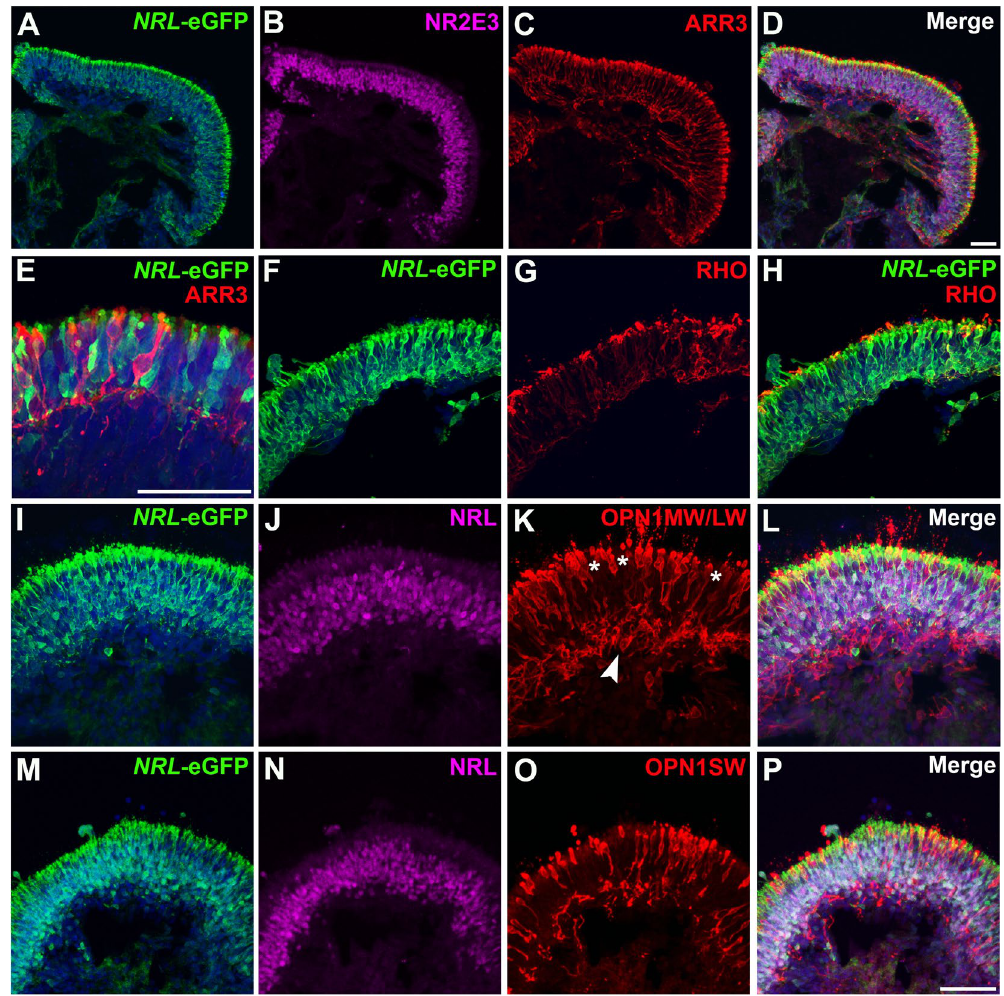
Figure 5. eGFP labeling of rods in mid-stage NRL + /eGFP OVs. To examine mid-stages of rod differentiation in NRL + /eGFP OVs, d145 OVs were analyzed. ( A,B ) A large increase in rod production was observed by d145, as shown by co-expression of NRL -eGFP + ( A ) and NR2E3 ( B ). ( C , D ) Numerous ARR3 + cones were also present at this time ( C ; merged image in D ). ( E ) Higher magnification image of showing non-overlapping NRL -eGFP and ARR3 labeling in rods and cones. ( F–H ) Many NRL -eGFP + rods ( F ) also expressed rhodopsin (RHO) ( G ; merged image in H ) at this stage of differentiation. ( I–P ) Analysis of NRL -eGFP and NRL expression relative to red/green cone opsin (OPN1MW/LW; I – L ) or blue cone opsin (OPN1SW; M – P ) expression showed complete segregation of all cone opsins from NRL -eGFP + /NRL + cells. Note the predominant localization of cone opsin- expressing cells along the outer (apical) portion of OVs (asterisks in K ), although some cones were also found beneath the organized photoreceptor outer nuclear layer (arrowhead in K ). Scale bars = 50 µ